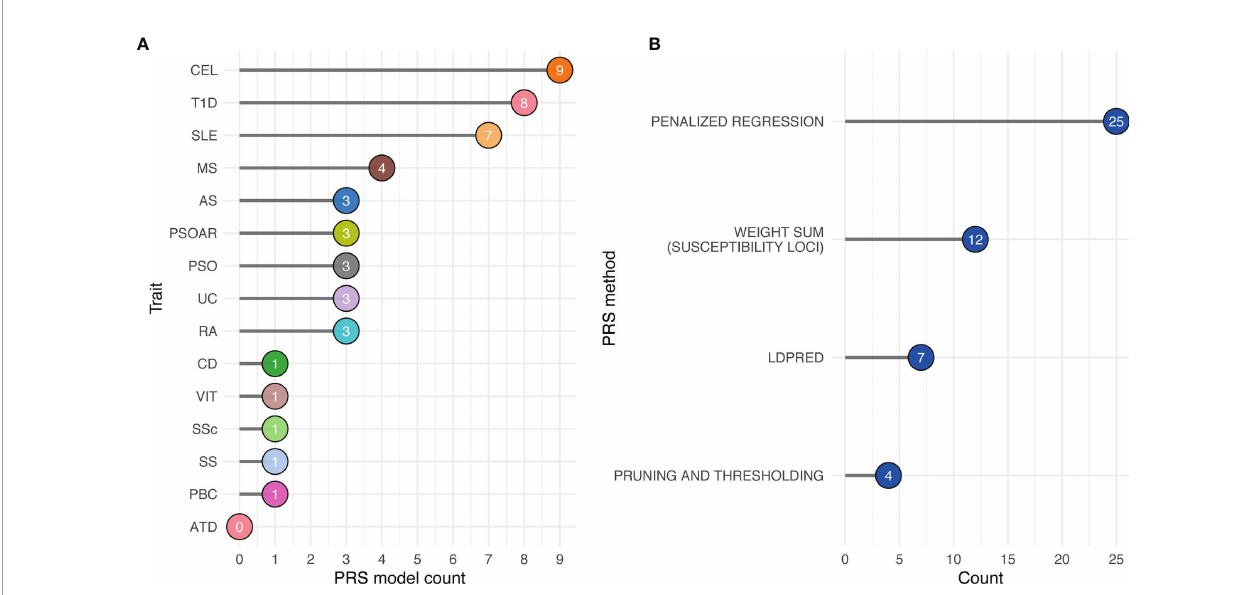
FIGURE 3 | Availability of autoimmune PRS models from Polygenic Score Catalog. (A) Number of available PRS models by trait. (B) Number of available PRS models by PRS method. Penalized regression : LASSOSUM, snpnet, L1-penalized support vector machine. Weighted sum (susceptibility loci) : GWAS signi fi cant variants, HLA-speci fi c signi fi cant variants, GWAS fi ne-mapped variants, and SNPs curated from literatures. LDpred : LDpred and